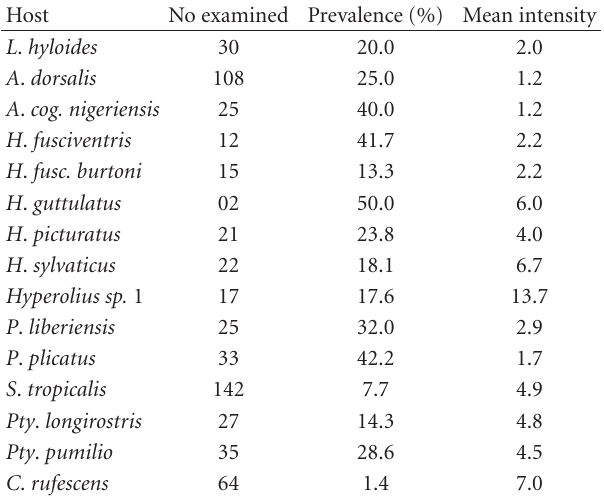
Table 4: Prevalence of proteocephalid cestode larvae in the anurans at the Okomu National